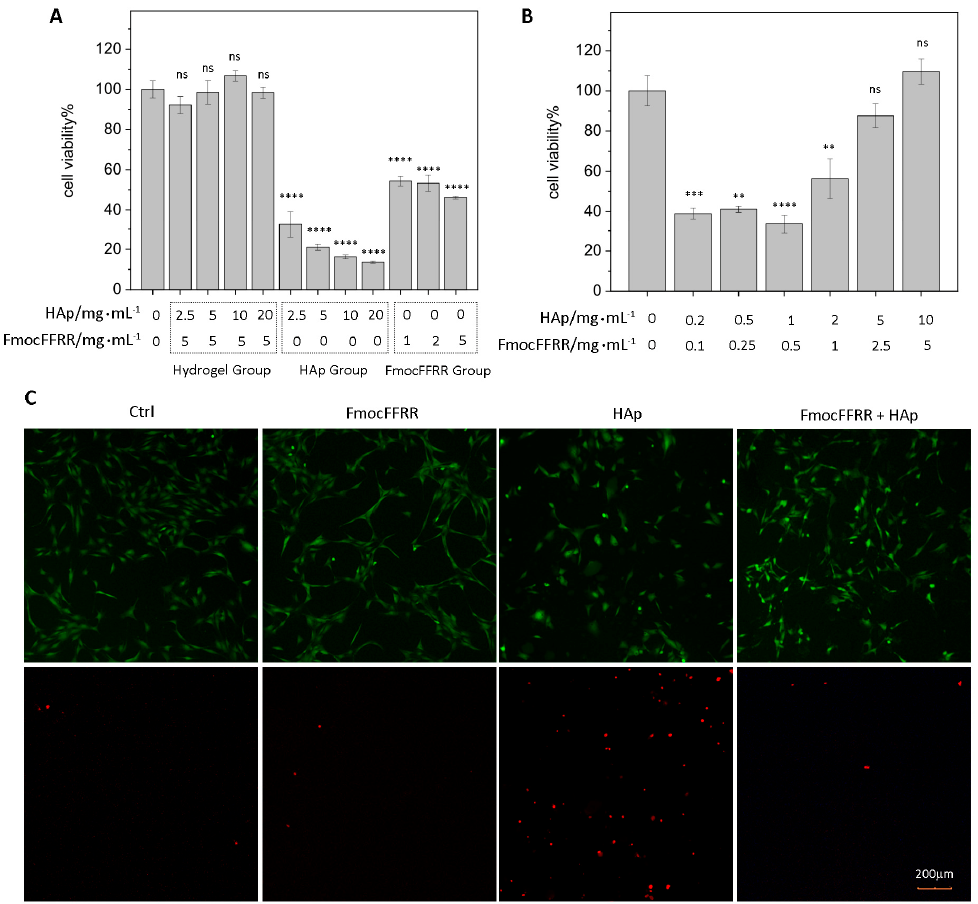
Figure 5. ( A ) MC3T3-E1 cell suspensions were mixed with freshly prepared FmocFFRR/HAp mixture for in situ gelations (hydrogel group), with free HAp particles (HAp group), or with FmocFFRR assemblies (FmocFFRR group). For the controlled groups, MC3T3-E1 cell suspensions were mixed with culture media. Cells were allowed for cultured for another 48 h and the cell viability was eval- uated. ( B ) Cell viability of MC3T3-E1 cells after culturing in FmocFFRR/HAp hydrogels at different concentrations with a fixed 1:2 weight ratio. ns: non-significant; **: p < 0.01; ***: p < 0.001; ****: p < 0.0001. ( C ) Live-dead staining of MC3T3-E1 cells after culturing in FmocFFRR/HAp (5.0/10.0 mg/mL) hydrogel, or treated with free HAp particles (10.0 mg/mL), FmocFFRR assemblies (5.0 mg/mL) for 48 h. The controlled cells were seeded on a tissue-culture plate. Green channels indi- cated live cells; red channels indicated dead cells, respectively.